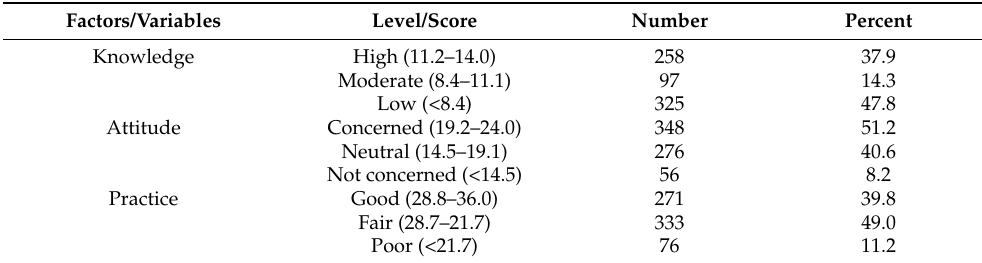
Table 2. Distribution of scores for knowledge, attitude, and practice among farmers in Nakhon Sawan (N = 680).